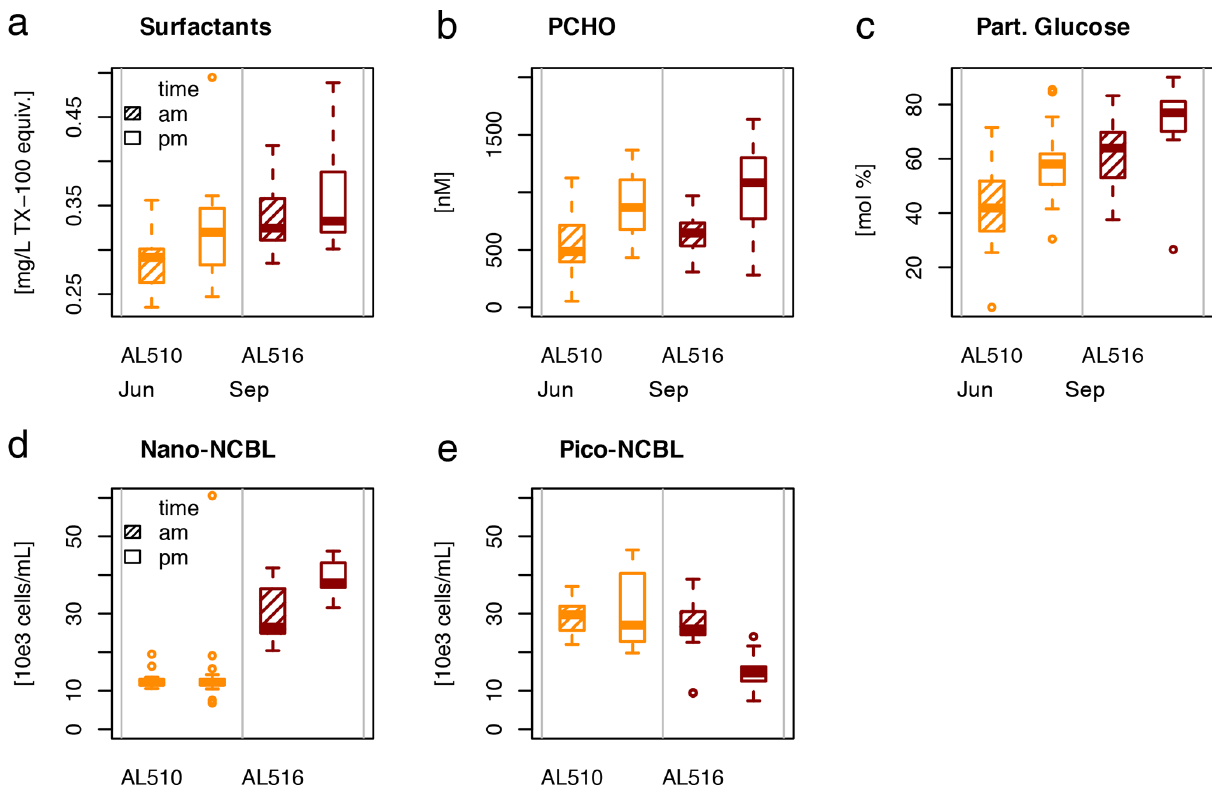
Figure 7. Diurnal variability in (a) surfactant, (b) particulate carbohydrate (PCHO) concentration, (c) mole percent of particulate glucose, and selected phytoplankton groups: cyanobacteria-like (CBL) cells contain the pigment phycoerythrin while non-CBL (NCBL) cells contain solely chlorophyll a . NCBL cells represented here differ in size; i.e. they (d) range from approx. 2–10µm (nano) or (e) are smaller than 2µm in size (pico). Abbreviations: morning (am) and afternoon